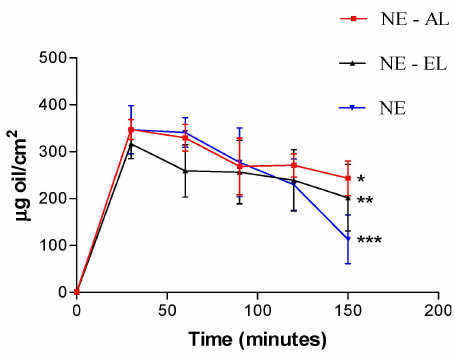
Figure 14. Skin oiliness in function of time after nanoemulsion application. * p < 0.05 vs NE-AL in time 0, 30, 60, 90 and 120 min. ** p < 0.05 vs. NE-EL in time 0, 30, 60, 90 and 120 min. *** p < 0.05 vs. NE in time 0, 30, 60, 90 and 120 min.